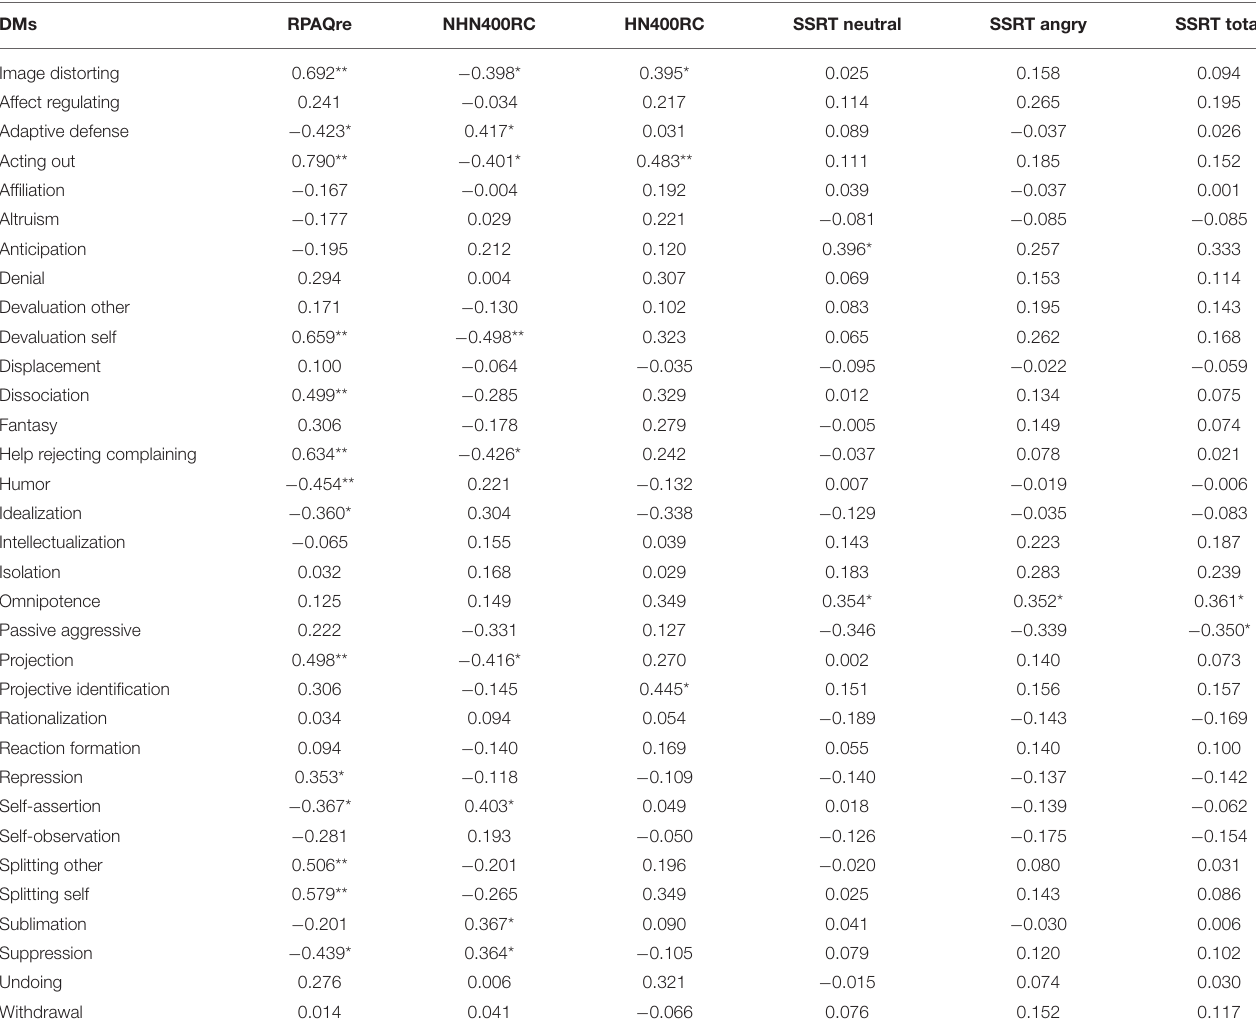
TABLE 3 | Correlations among defense mechanisms, reactive aggression total score, N400 effect and stop signal reaction time